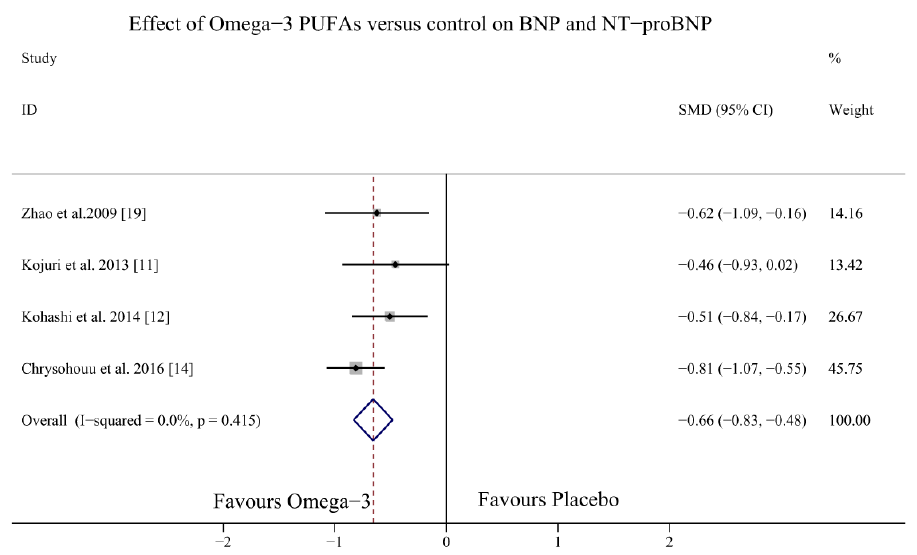
Figure 4. Forest plot depicting the effects of omega-3 PUFAs on BNP and NT-proBNP levels (SMD, standardised mean difference). Abbreviations: BNP, brain natriuretic peptide; NT-proBNP, N-terminal pro B-type natriuretic peptide PUFAs, polyunsaturated fatty acids